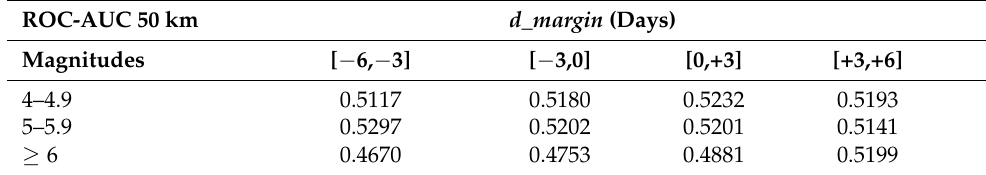
Table 6. ROC-AUC values for radius = 50 km